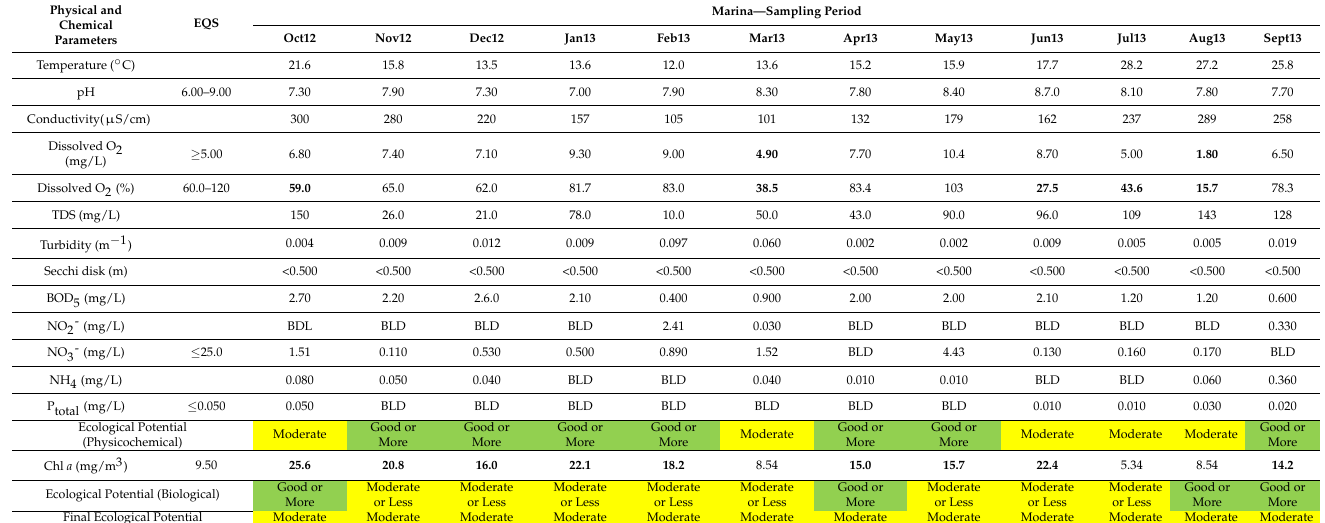
Table 2. Marina results of the general physical and chemical parameters measured in situ, and bio- chemical oxygen demand (BOD 5 ), nitrates (NO 3 − ), nitrites (NO 2 − ), ammoniacal nitrogen (NH 4 ), and total phosphorus (P total ). The biological element phytoplankton [Chlorophyll-a (Chl-a) concentration. The Ecological Potential was classified according to [22]. BDL—Below Detection Limit. Bold values stand for outside the established environmental quality standards (EQS) established by WFD for northern Portuguese reservoirs